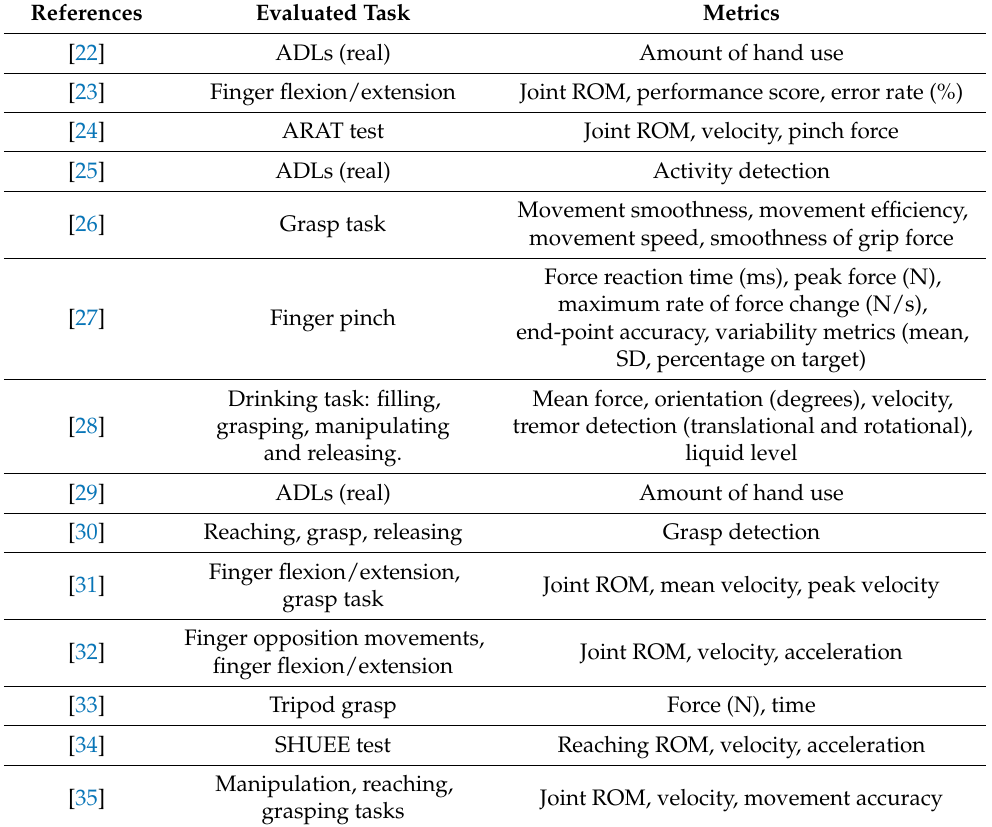
Table A1. Supplementary data extracted from included